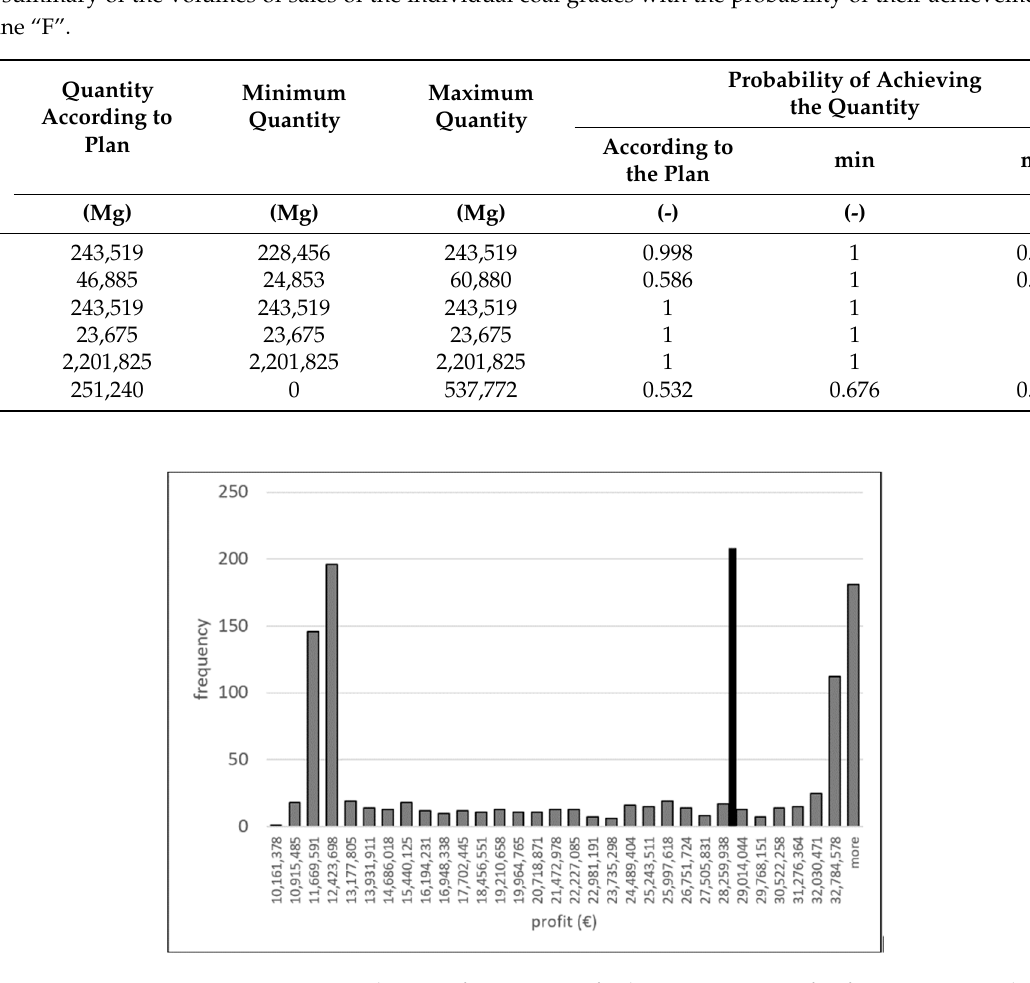
Figure 6. Histogram showing frequencies of achieving given profits for mine “F” with dispersion σ yprog . * The black vertical line illustrates the nominal value quantity (according to the optimal plan from Table 7).